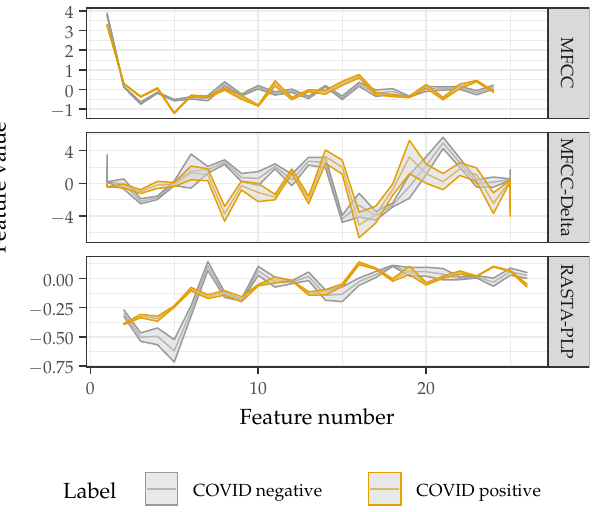
Figure 3. Average and standard deviation of the feature values extracted from three frames of a single subject saying ‘bye’ both with and without